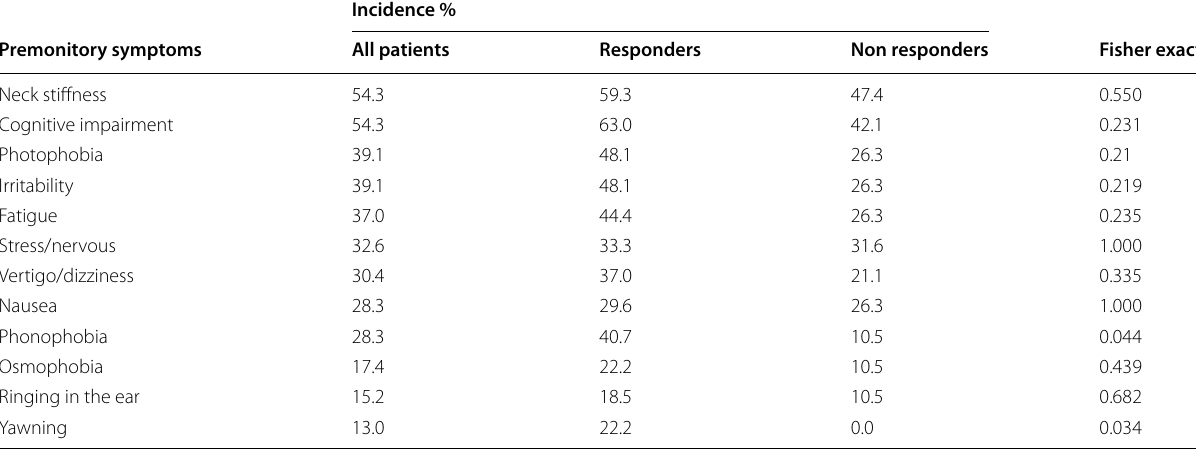
Table 4 Incidence of premonitory symptoms that were followed by headache prior to galcanezumab